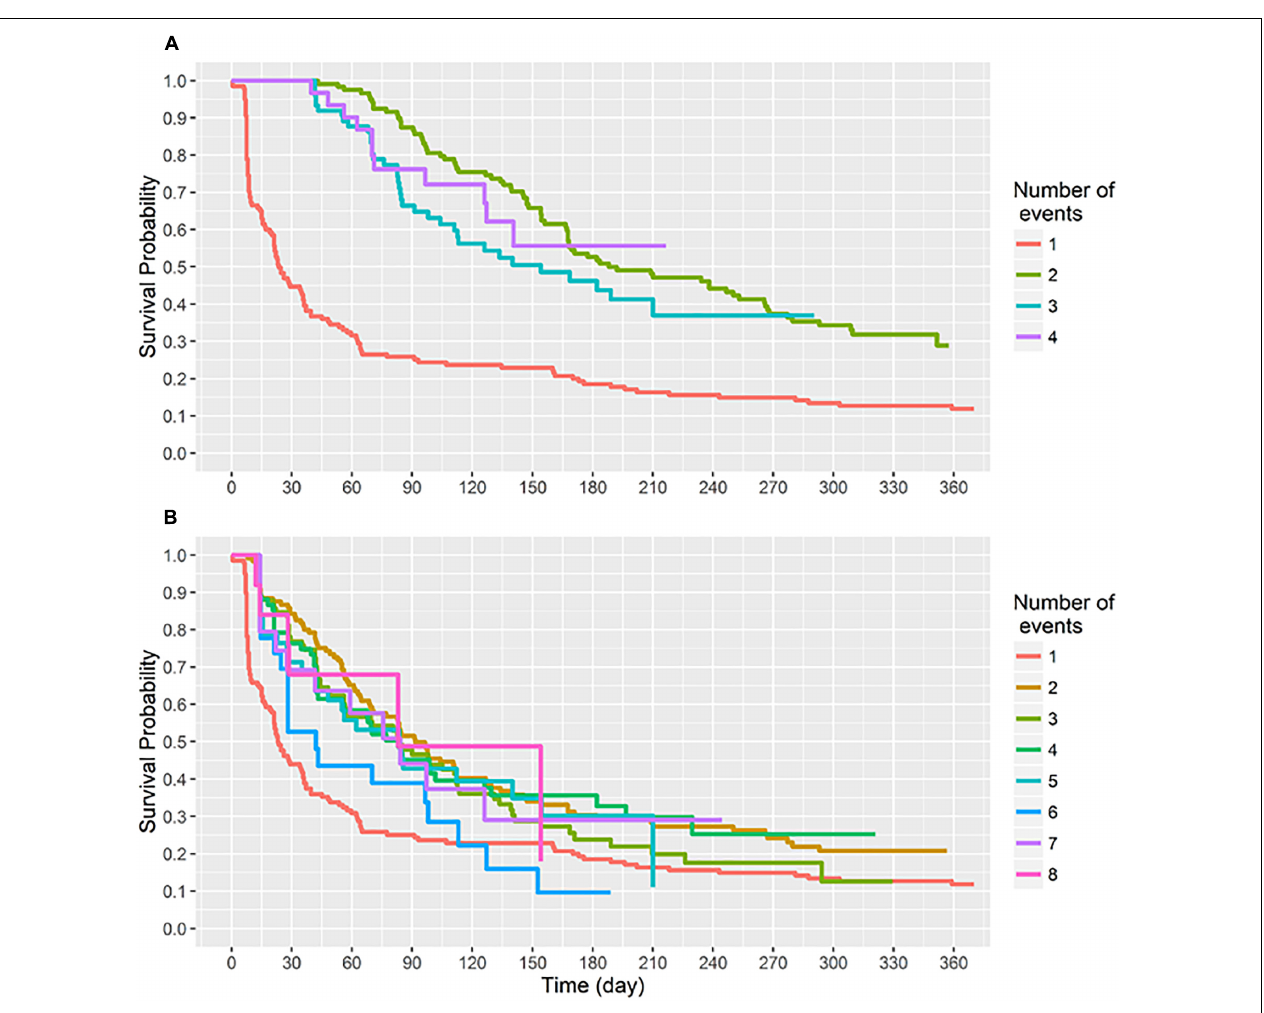
FIGURE 2 | Survival time (days) to sequential S. aureus acquisition (1st, 2nd, 3rd, etc.) events. Recurring acquisition events both at (A) the species and (B) the genotype levels were assessed using the conditional gap-time model. (A) Acquisition events analyzed at the species level. Two infants had five acquisition events, these have been omitted. (B) Acquisition events analyzed at the genotype level. Two infants had nine acquisition events, these have been omitted.